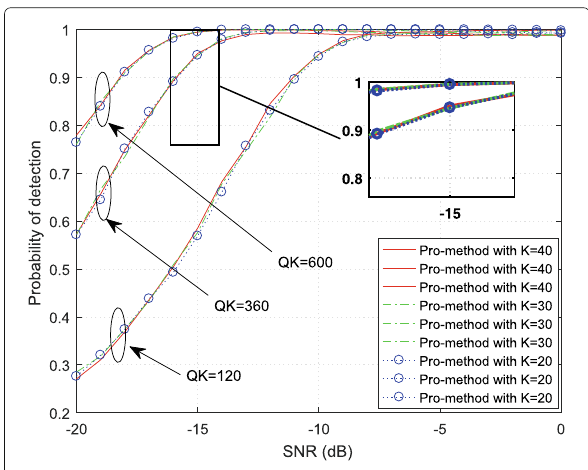
Fig. 7 ROC curves of the proposed method with QK = 600,360,120 and K = 40,30,20 at SNR= − 15